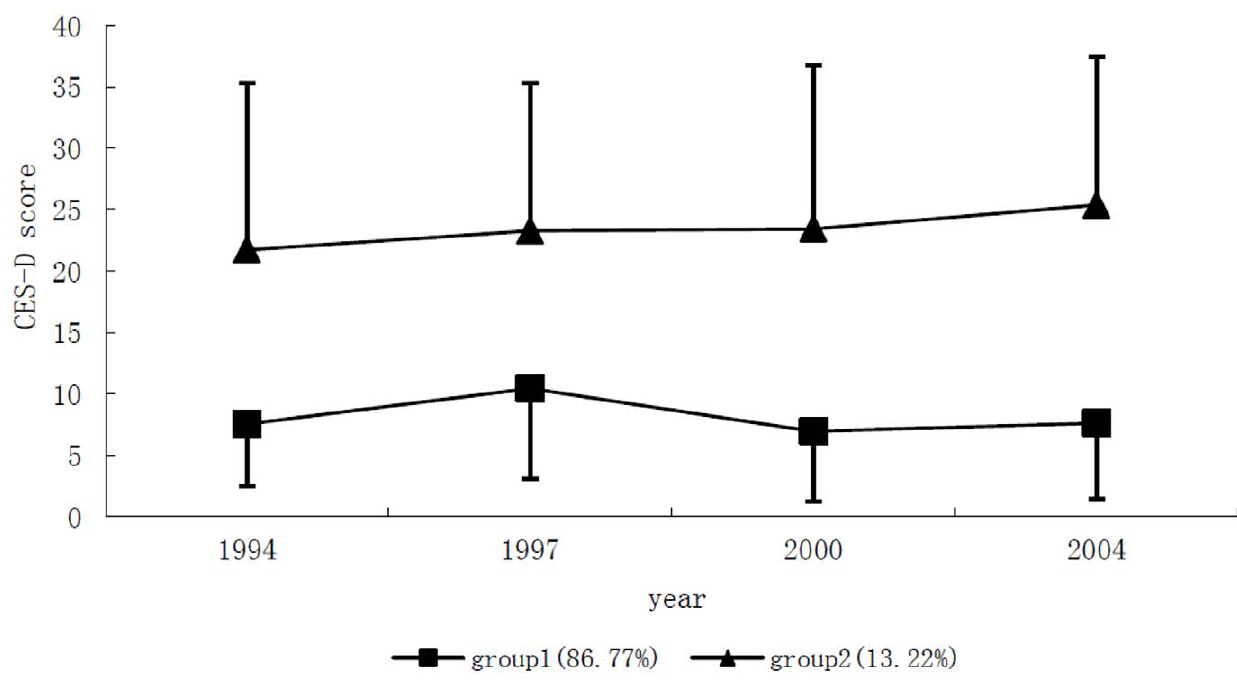
Figure 2. Trajectories of CES-D score over time. Bar represented the SD for CES-D score in each group in every visit.